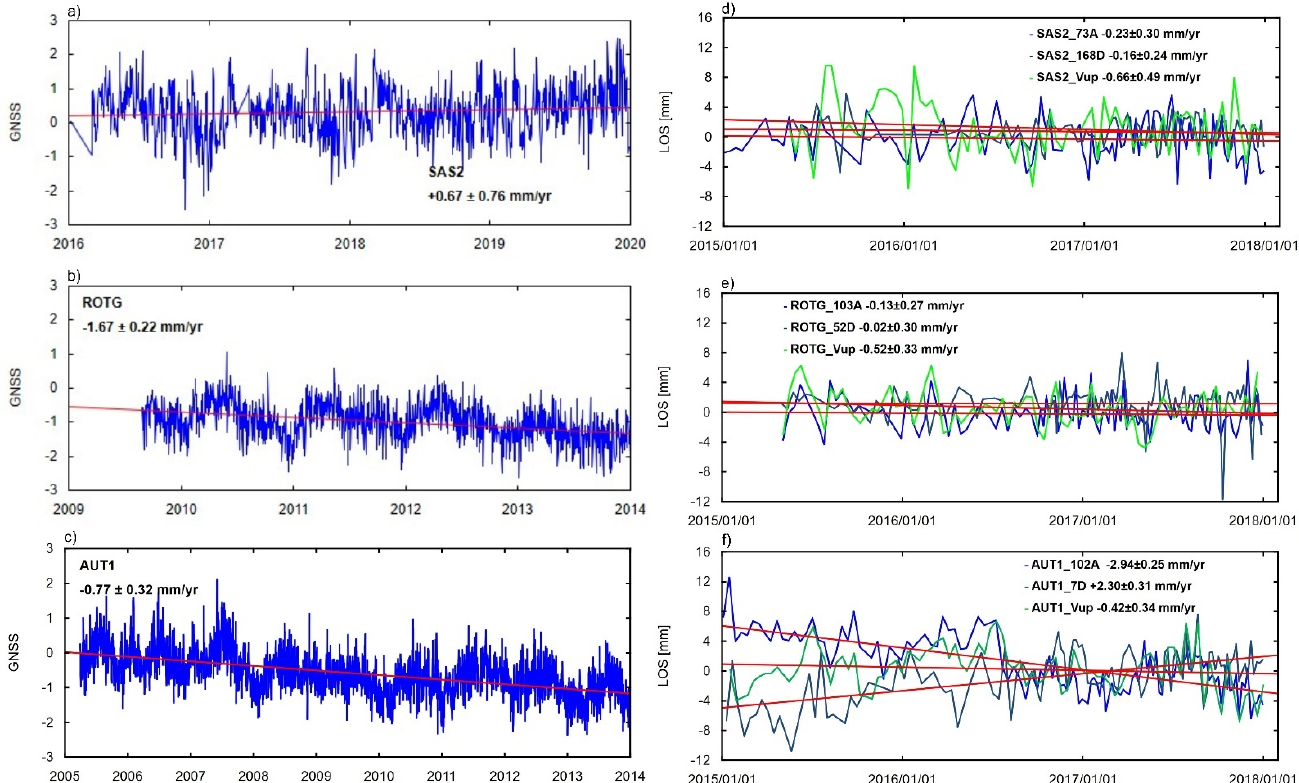
Figure 5. ( a – c ) The time series of 3 selected GNSS stations from a total of 27 stations. ( d – f ) The units are in centimetres. The time series is in the line of sight (LOS) displacement (in mm) of two persistent scatterer points with an ascending and descending track within GNSS stations. The time series are displayed with arbitrary offsets for presentation purposes.